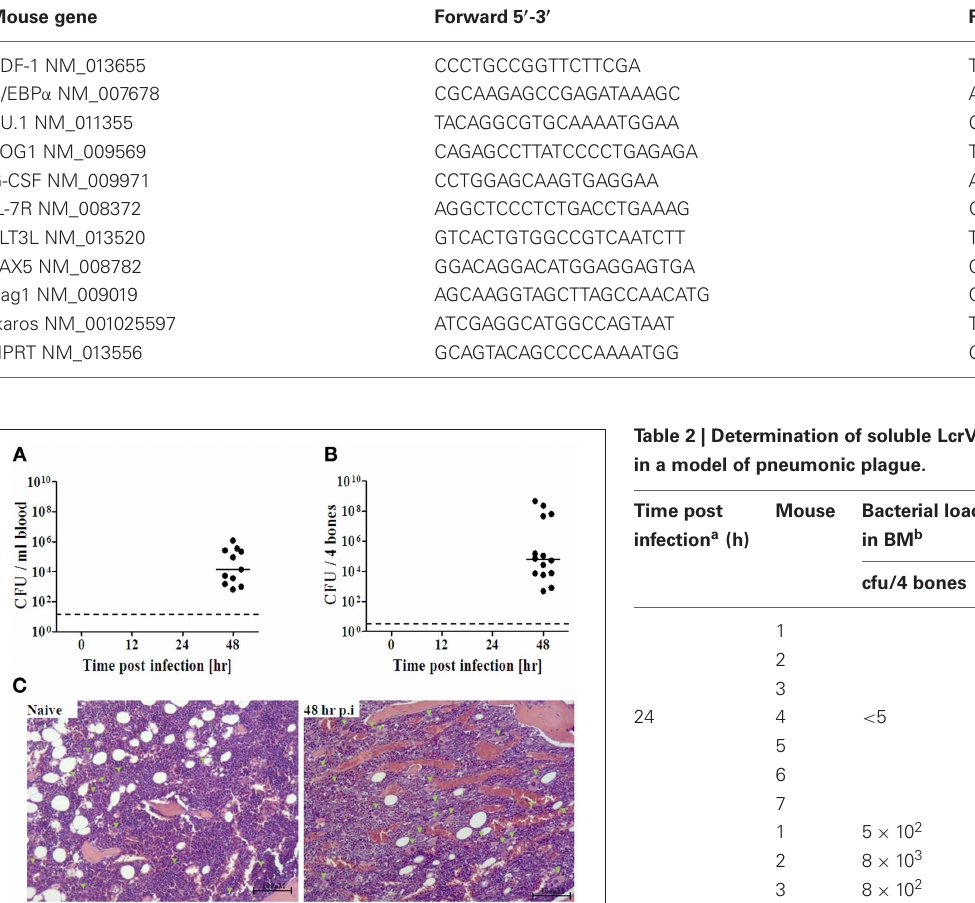
Table 1 | Sequences of primers used in this study. Mouse gene